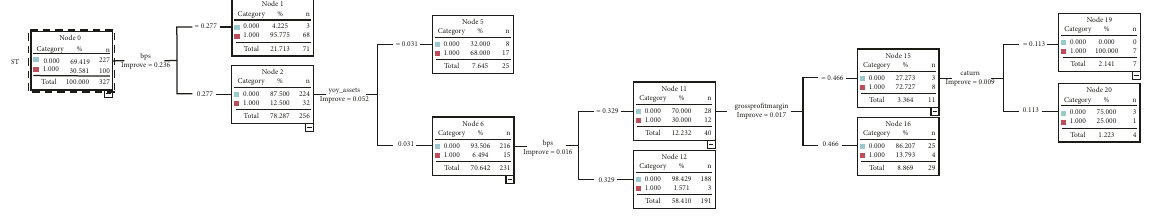
Figure 6: CART decision tree diagram.